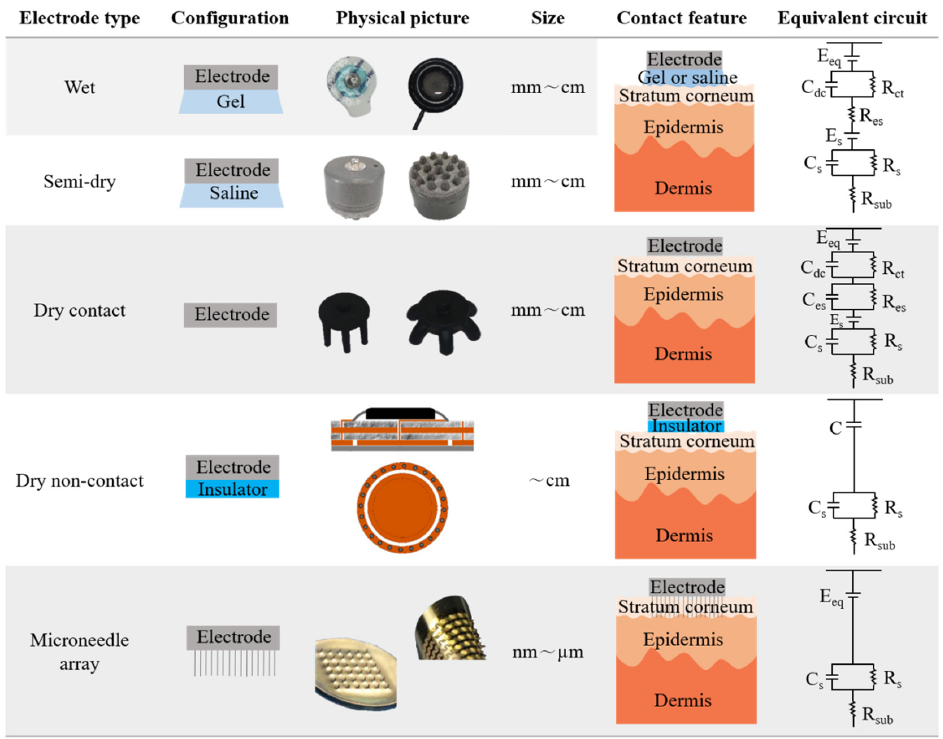
Figure 2. Summary of electrode configuration, electrode-skin contact features, and electrical equivalent circuits of different types of EEG electrodes. (The electrode schematic diagram and equivalent circuit diagram are referenced from the literature [9,22]. Photographs of wet and dry electrodes are provided by grael, semi-dry electrodes are from [23], dry non-contact electrodes are from [24], and microneedle array electrodes are from [25,26]).